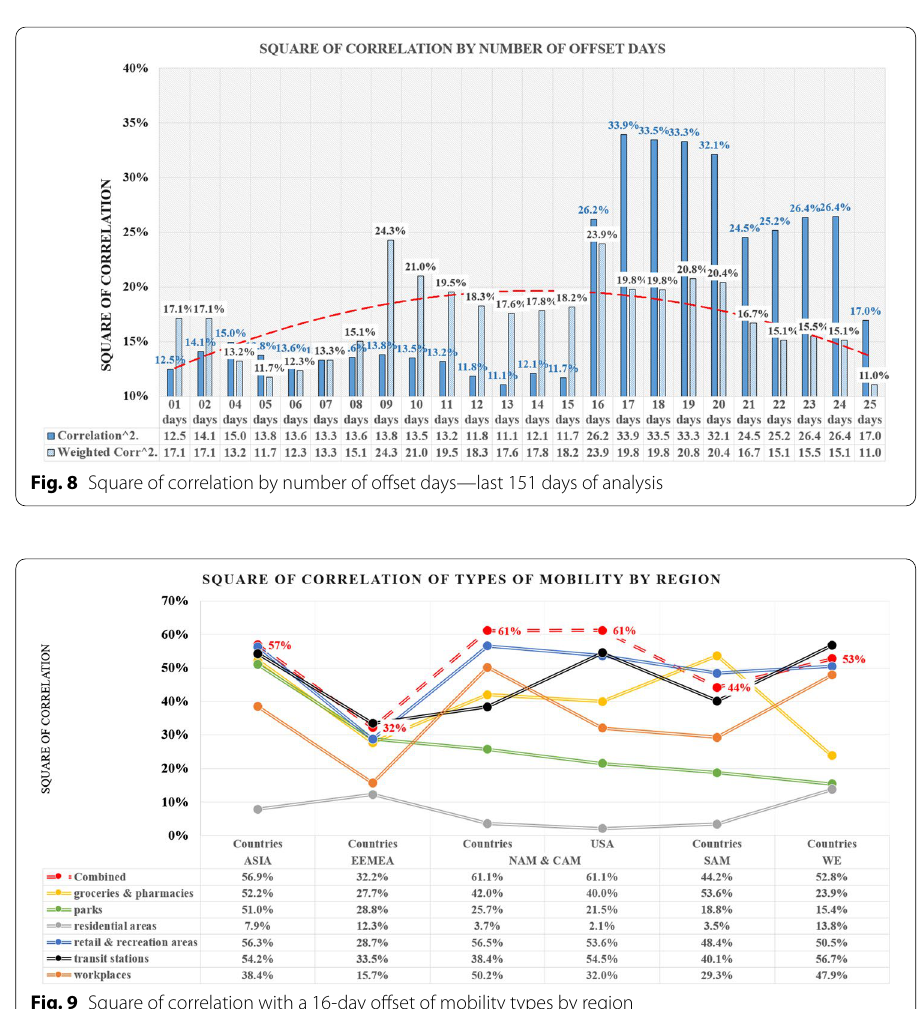
Fig. 9 Square of correlation with a 16-day offset of mobility types by